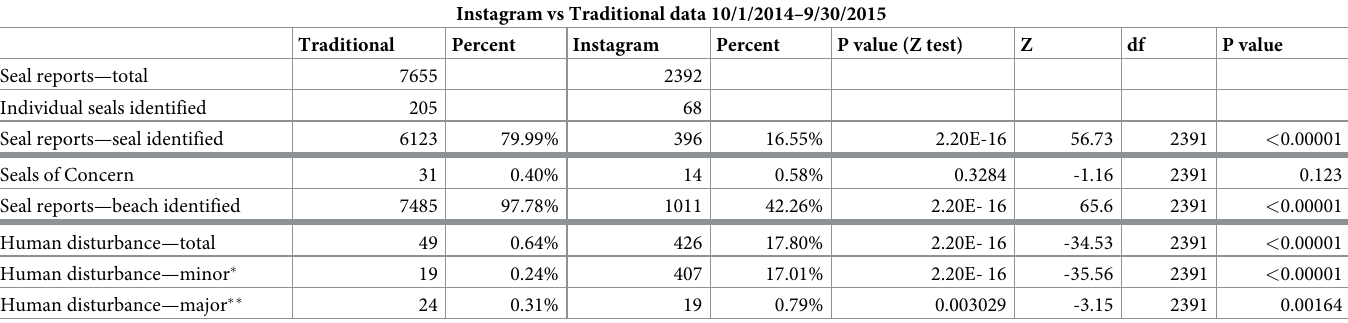
Table 1. Social media data vs traditional data for identifying Hawaiian monk seals, their locations and human disturbance. We show the number of seal reports obtained through traditional and Instagram-based reports, and results of z tests comparing the proportions of reports with seals/beaches identified and disturbances